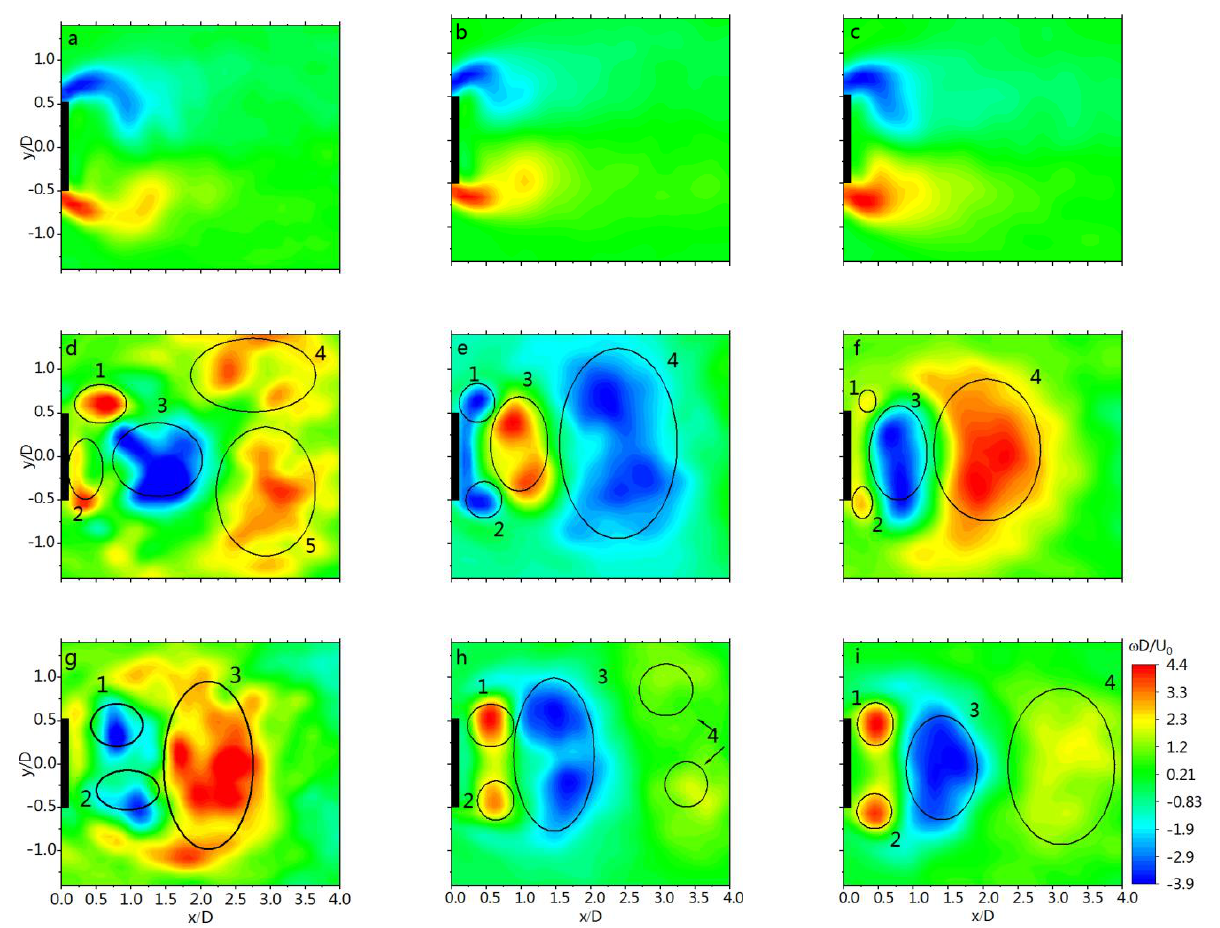
Figure 10. The modes of Proper Orthogonal Decomposition of Ar = 0.2: ( a ) Re = 1000, the zeroth-order mode (mean vorticity field); ( b ) Re = 2000, the zeroth-order mode (mean vorticity field); ( c ) Re = 5000, the zeroth-order mode (mean vorticity field); ( d ) Re = 1000, the first-order mode; ( e ) Re = 2000, the first-order mode; ( f ) Re = 5000, the first-order mode; ( g ) Re = 1000, the second-order mode; ( h ) Re = 2000, the second-order mode; ( i ) Re = 5000, the second-order mode.